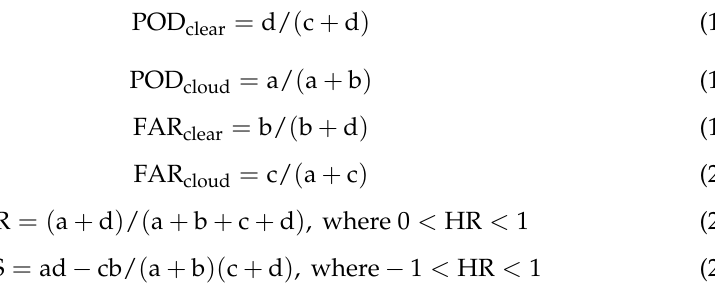
Table 8. The sites and locations of the four scenes for this verification experiment.